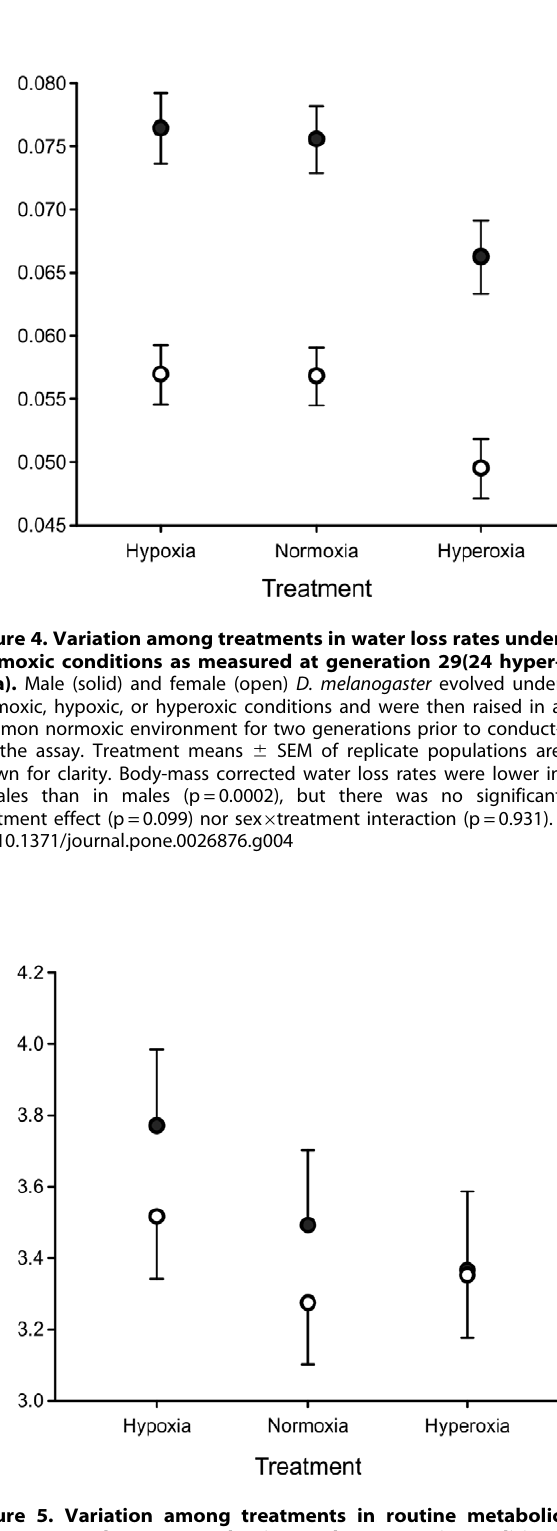
Figure 5. Variation among treatments in routine metabolic rate, measured as CO 2 production under normoxic conditions at generation 29(24 hyperoxia). Male (filled) and female (open) D. melanogaster were evolved under normoxic, hypoxic or hyperoxic conditions and were then raised in a common normoxic environment for two generations prior to conducting the assay. Treatment means 6 SEM of replicate populations are shown and, for clarity, error bars are omitted in one direction. There were no significant differences between the sexes (p=0.417) or treatments (p=0.163), and no evidence of a sex 6 treatment interaction (p=0.862).